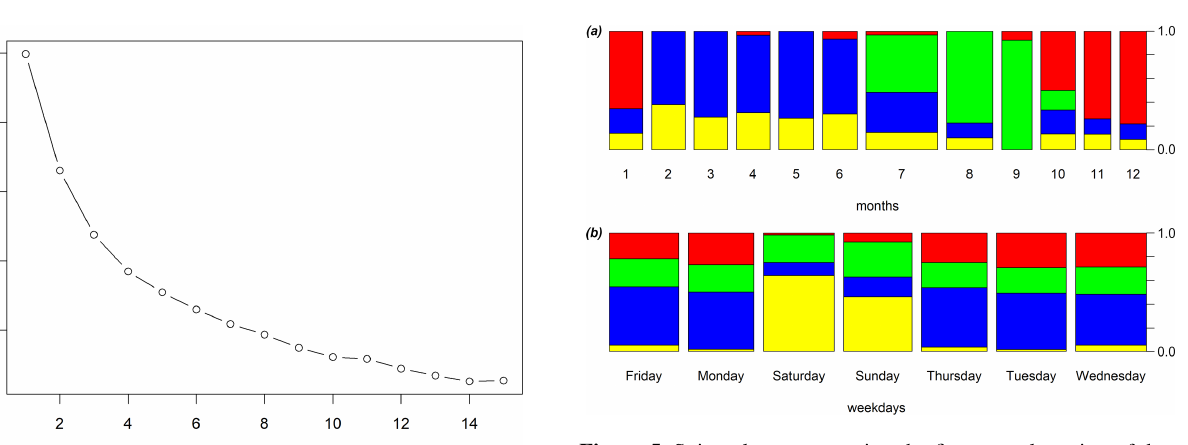
Figure 5. Spine plots representing the first-step clustering of days along (a) months and (b) days of the week (green: all days mostly occurring in July, August, and September; blue: working days mostly occurring from February to June; red: working days mostly occurring from October to January; yellow: weekends mostly oc- curring from October to